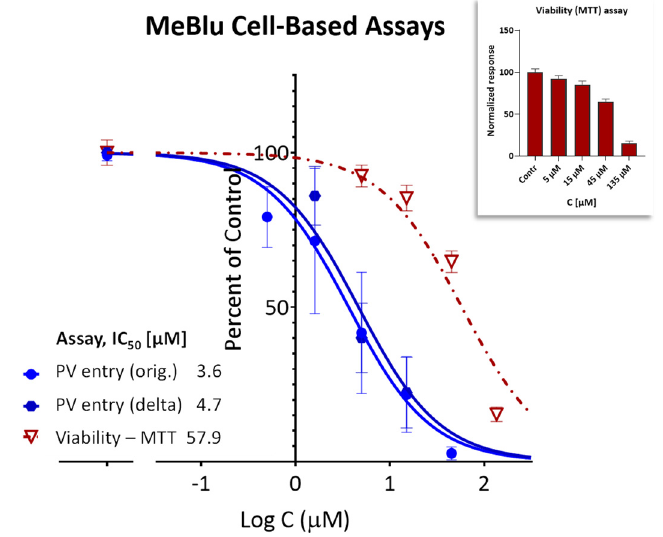
Figure 5. Therapeutic index of MeBlu in the present cell-based assay. Concentration-dependent activity (inhibition of the entry of SARS-CoV-2 BacMam-based pseudoviruses) and safety (effect on viability) of MeBlu in HEK293T cells. Inhibitory effects on the cell entry of pseudoviruses expressing the original and the delta mutant of the spike protein of SARS-CoV-2 (dark and light blue, respectively) shown in parallel with effects on cell viability (dark red; assessed via MTT assay) under the same conditions (48 h in the presence of MeBlu +48 h culture; also shown separately as a column graph in the inset).